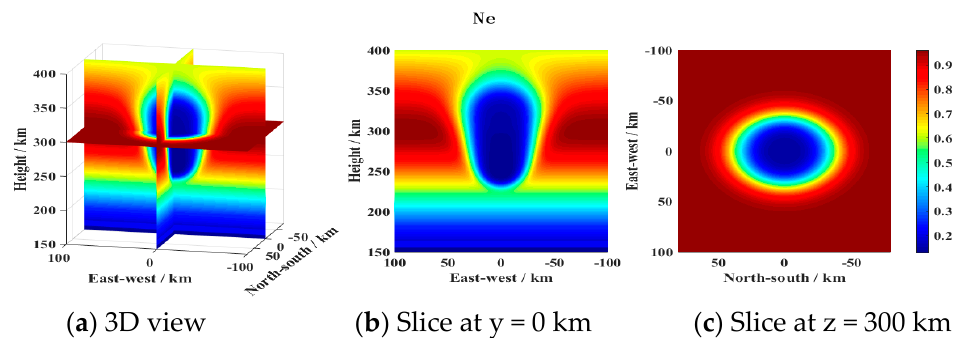
Figure 4. The 3D distribution of CO 2 concentration after 100 s release of CO 2 (CO 2 concentration unit: 10 6 cm − 3 ).